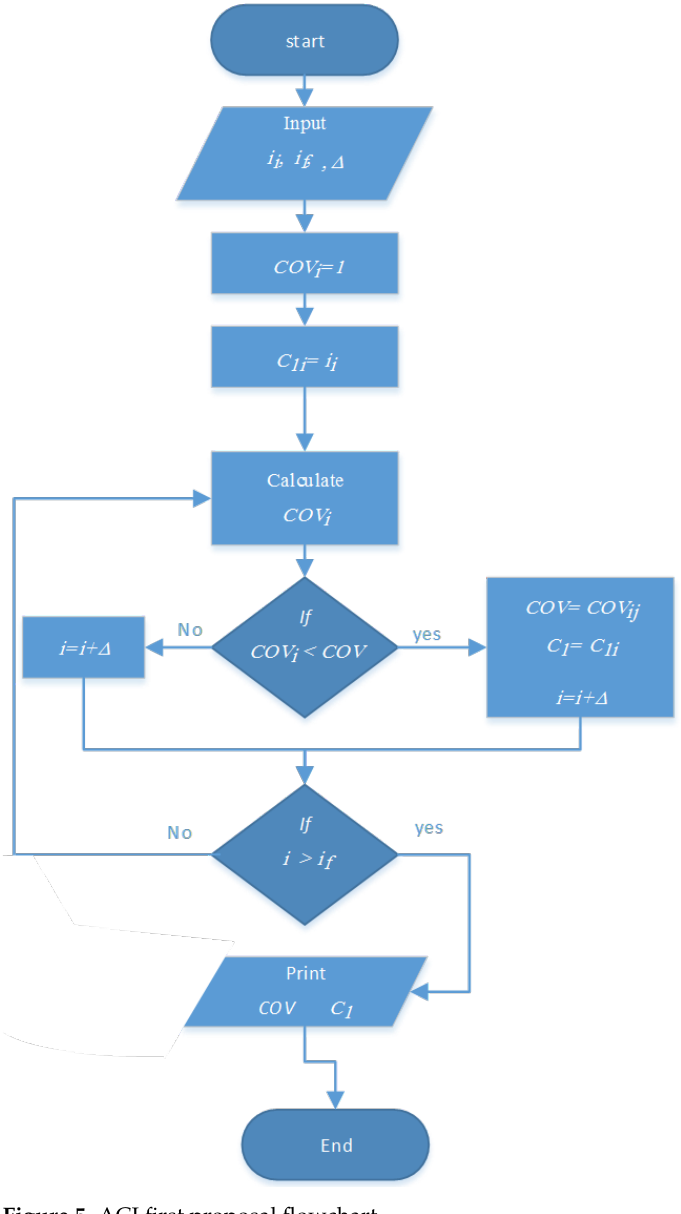
Figure 5. ACI first proposal flowchart.